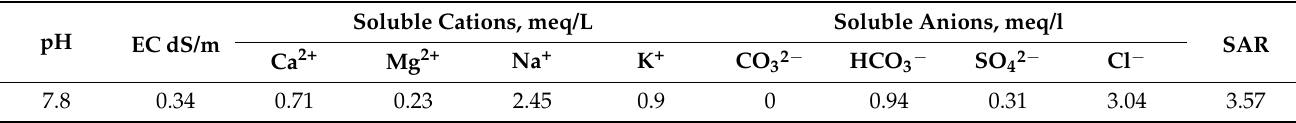
Table 1. Some chemical properties of irrigation water.